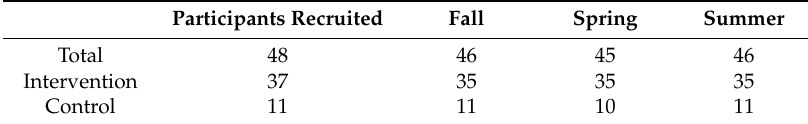
Table 1. Enrolment data.